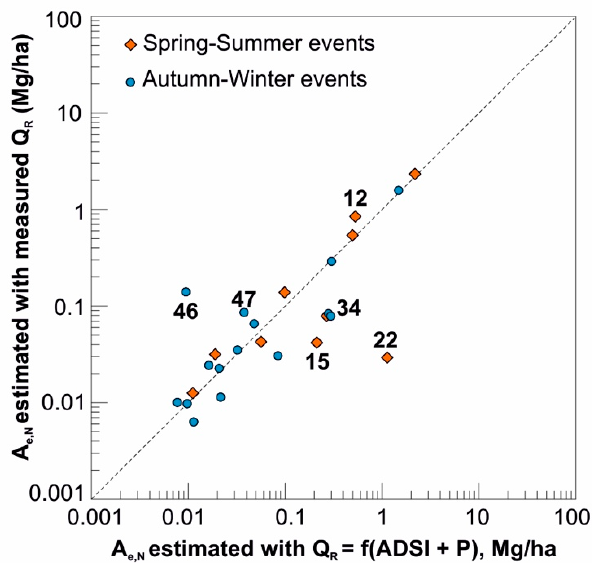
Figure 5. Comparison between the soil loss estimated by Equation (4) with the Q R measured and estimated as the ratio between the runoff, Q = f (ADSI + P), Equations (7a,b) and (8a,b), and the corresponding measured rainfall P. Blue dots and orange diamonds indicate autumn–winter and spring–summer events, respectively. The numbers associated with some selected events are referred to in Table S1.